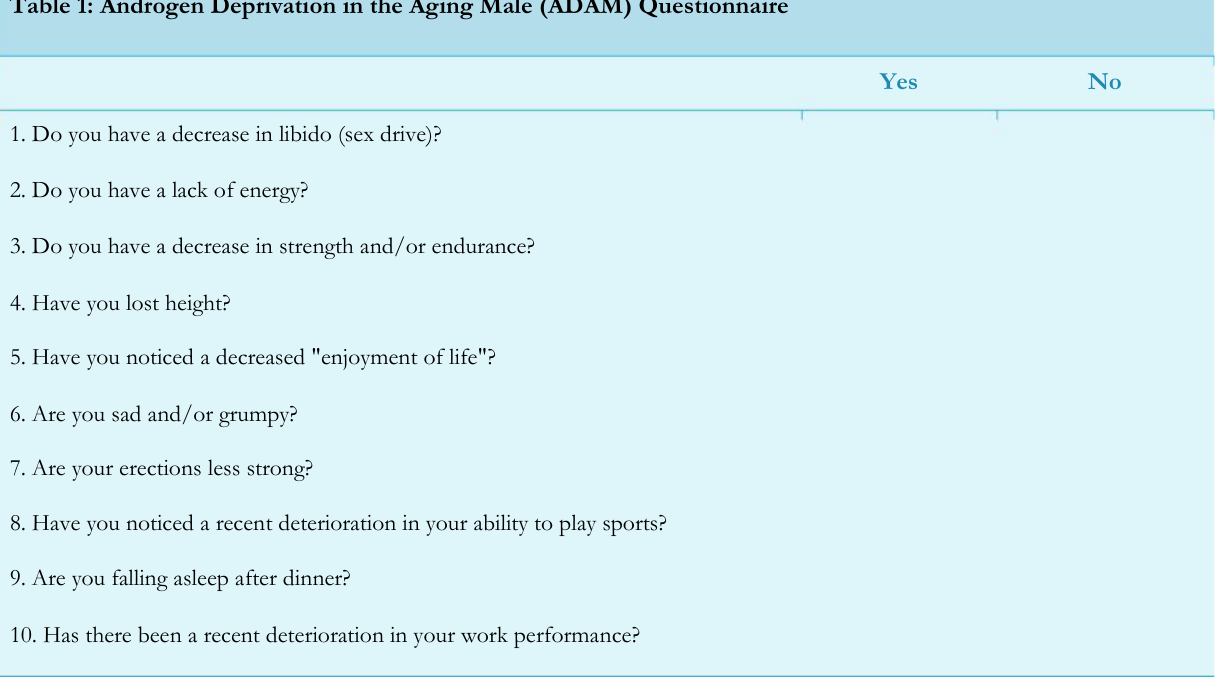
Table 1: Androgen Deprivation in the Aging Male (ADAM)